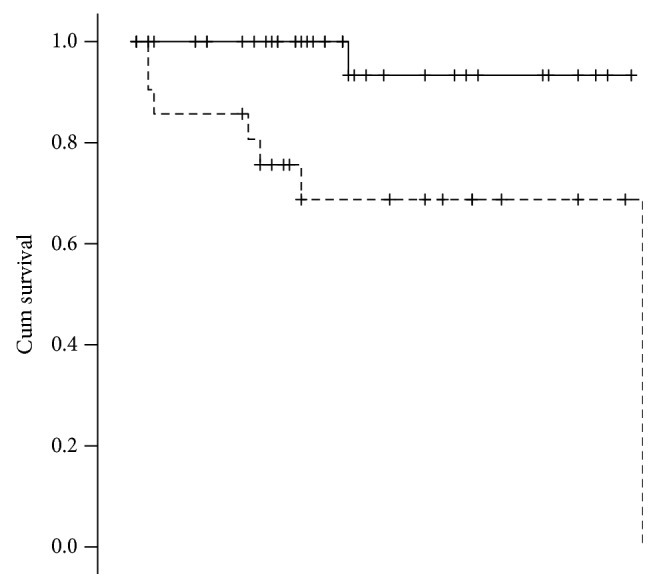
DFS Kaplan-Meier for lymph node involvement yes/no. p = 0.004; mean survival, no: 81.800 (75.741-87.859); yes: 64.404 (47.923-80.886).